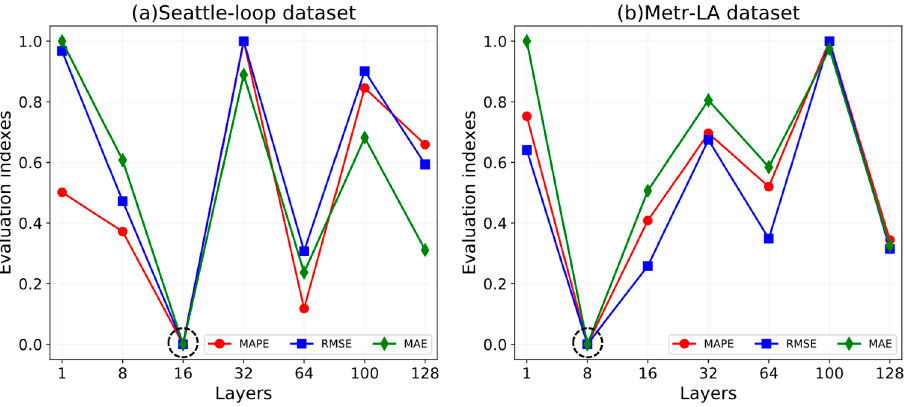
Figure 6. Impact of the hidden layers of GRN on the ST-CRMF model.